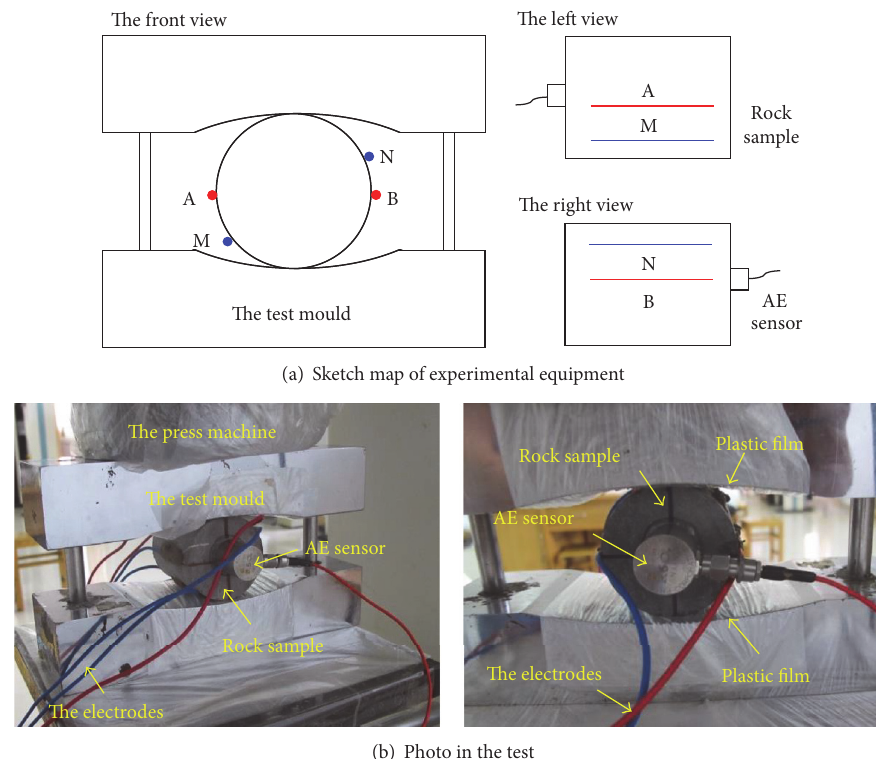
Figure 3: Experimental